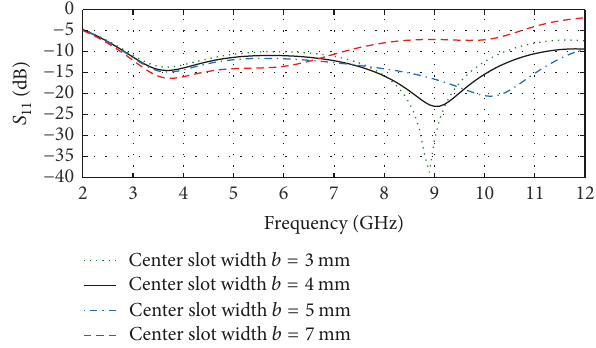
Figure 8: Effect of center slot width on impedance